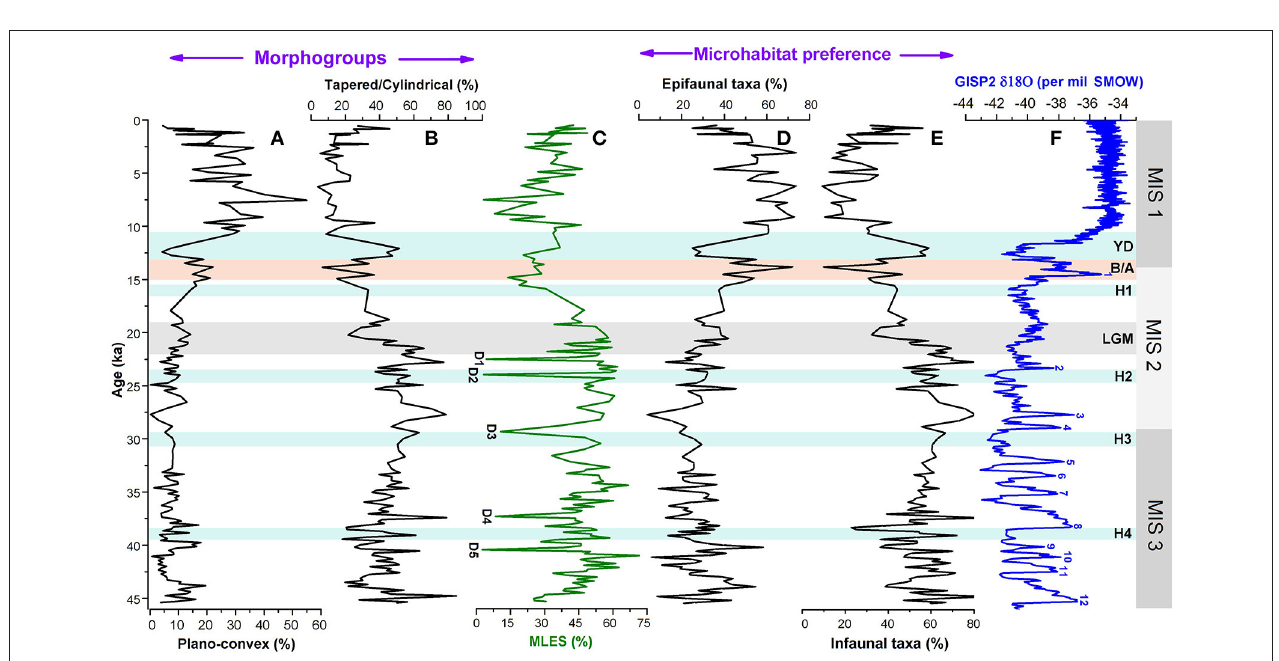
FIGURE 5 | Comparison of relative abundances of (A,B) major morphogroups (plano-convex and tapered/cylindrical), (C) mixed layer eutrophic species (MLES), and (D,E) microhabitat categories (epifaunal and infaunal taxa) of foraminiferal assemblages with (F) GISP2 δ 18 O ice core record. D1–D5 represents possible dissolution points following Verma et al. (under revision). MIS 1–3 denotes the Marine Isotope Stages; H1–H4, Heinrich Events; YD, Younger Dryas; B/A, Bølling/Allerød; LGM, Last Glacial